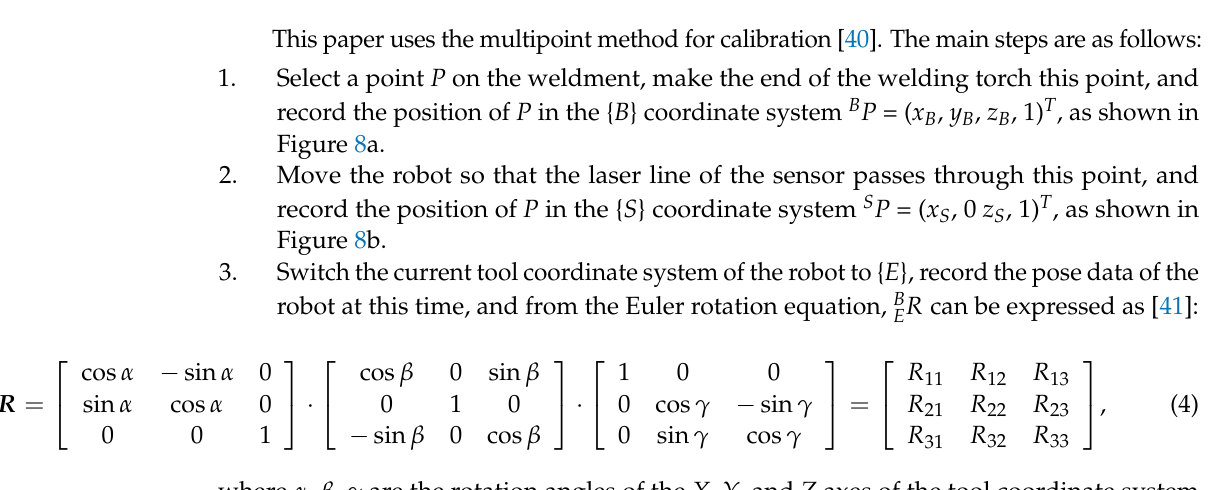
Figure 7. Relationship between two coordinate systems.